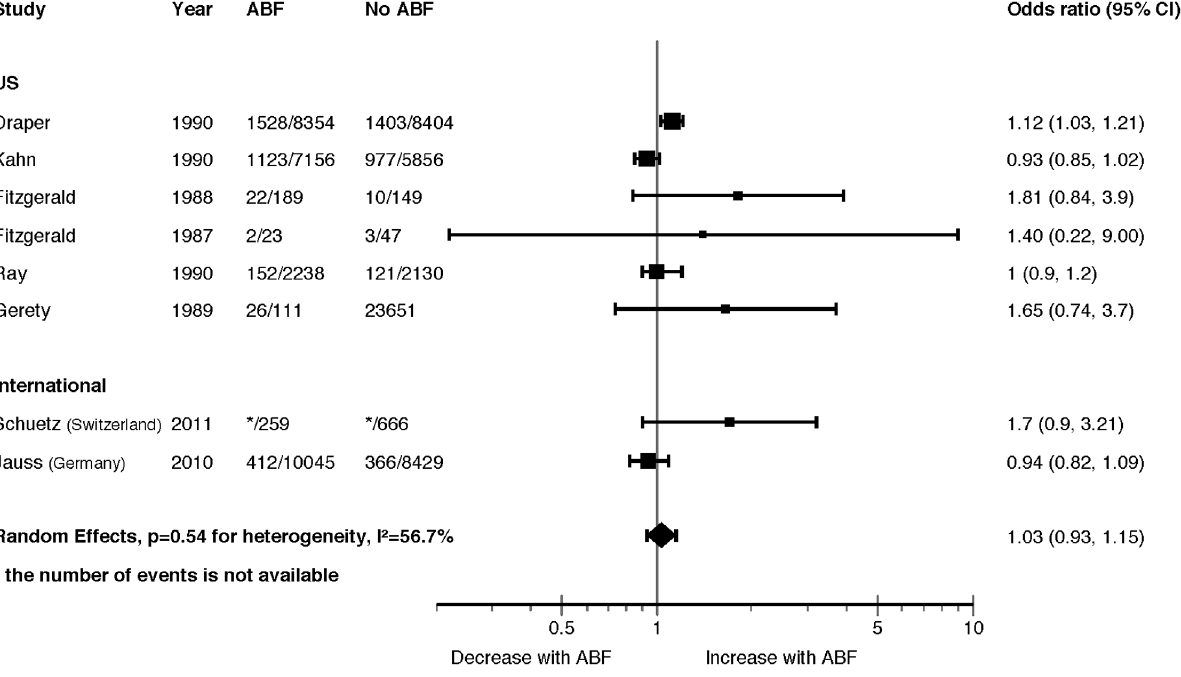
Figure 2. Acute Care Mortality Forest Plot. doi:10.1371/journal.pone.0109975.g002 PLOS ONE |